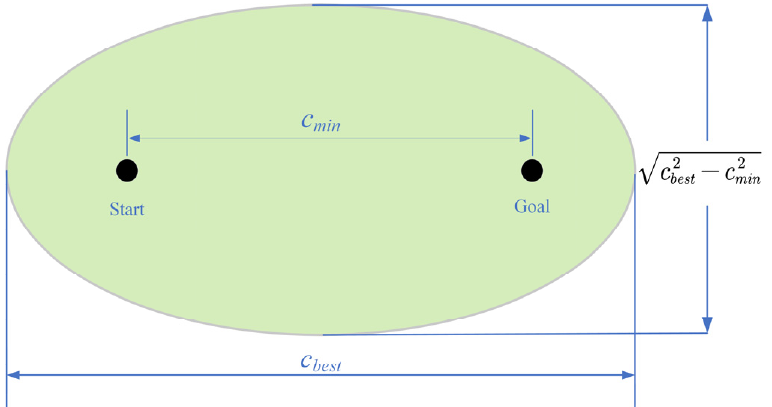
Figure 4. Single elliptic